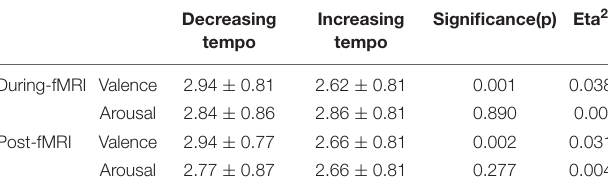
TABLE 1 | The ratings of valence and arousal evoked by